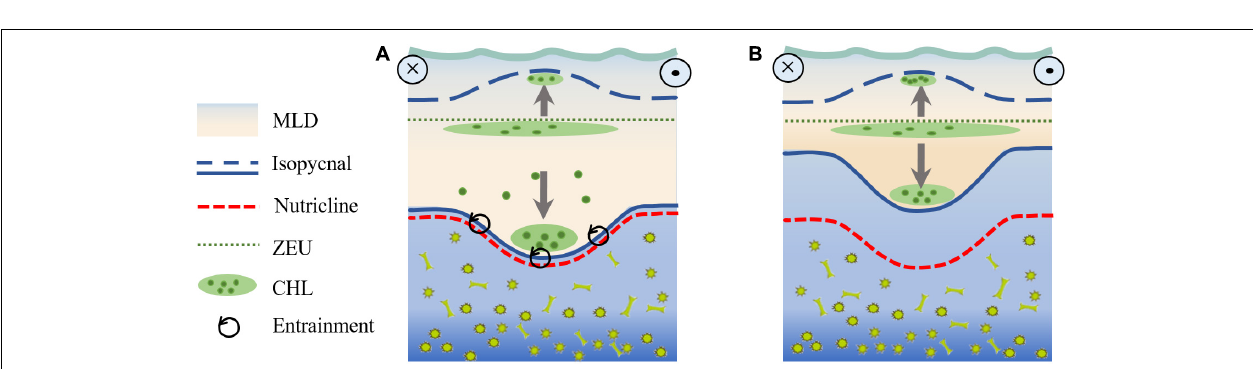
FIGURE 13 | Time series of the main axis of Kuroshio in its southernmost position and regionally averaged (132 ◦ − 140 ◦ E and 28 ◦ − 35 ◦ N) log10 transformed Brunt-Vaisala frequency squared in 2017 (A,C) and 2018 (B,D) . The black lines represent 10-day smoothed curves.